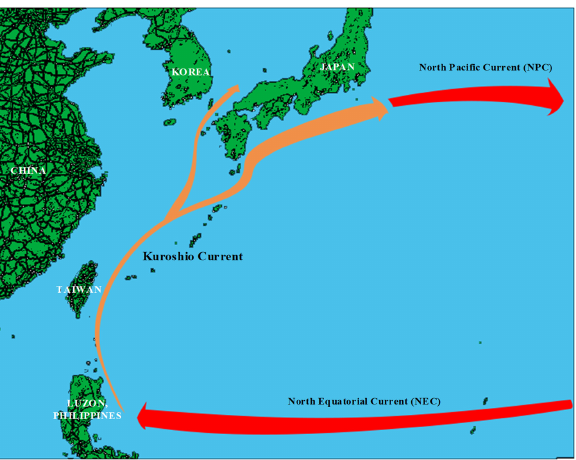
Figure 1. Schematic drawing for the path of Kuroshio current on the western North Pacific Ocean.